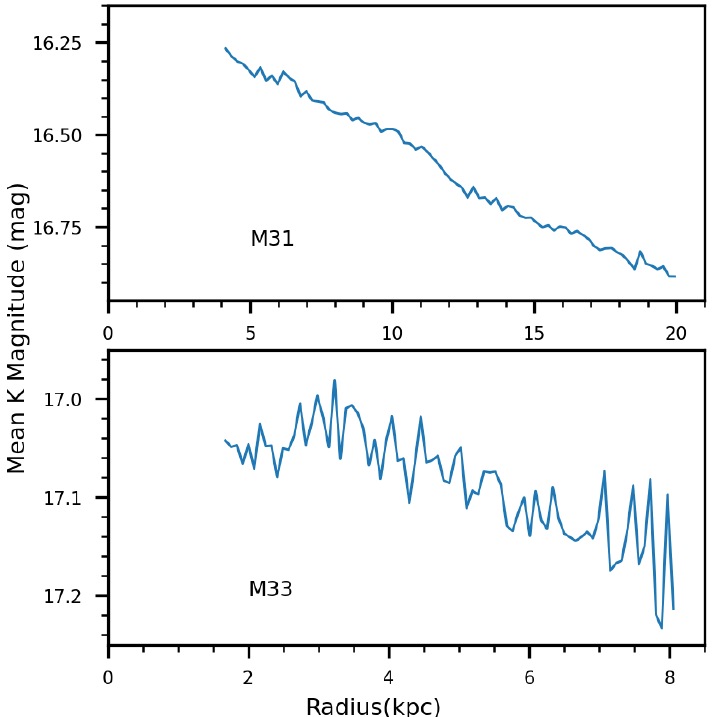
Figure 9. The radial distribution of the mean K magnitude of the sources labelled as C-AGBs or O-AGBs in M31 ( upper ) and M33 ( bottom